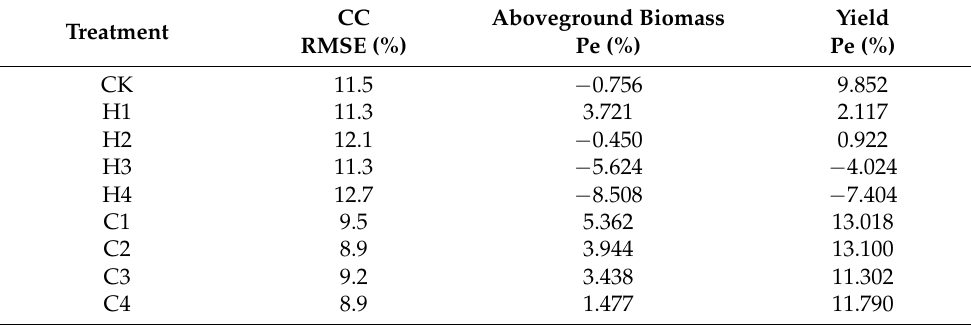
Table 5. Calibration results of AquaCrop model crop